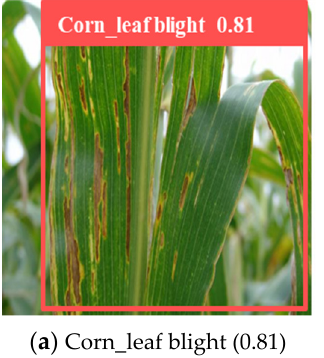
Figure 15. Partial example images of classification results of transfer learning experiments. Represent- ing the disease type (confidence) are Corn_leaf blight (0.81) ( a ); Apple-scab (0.62) ( b ); Peanut_Rust (0.87) ( c ), respectively.